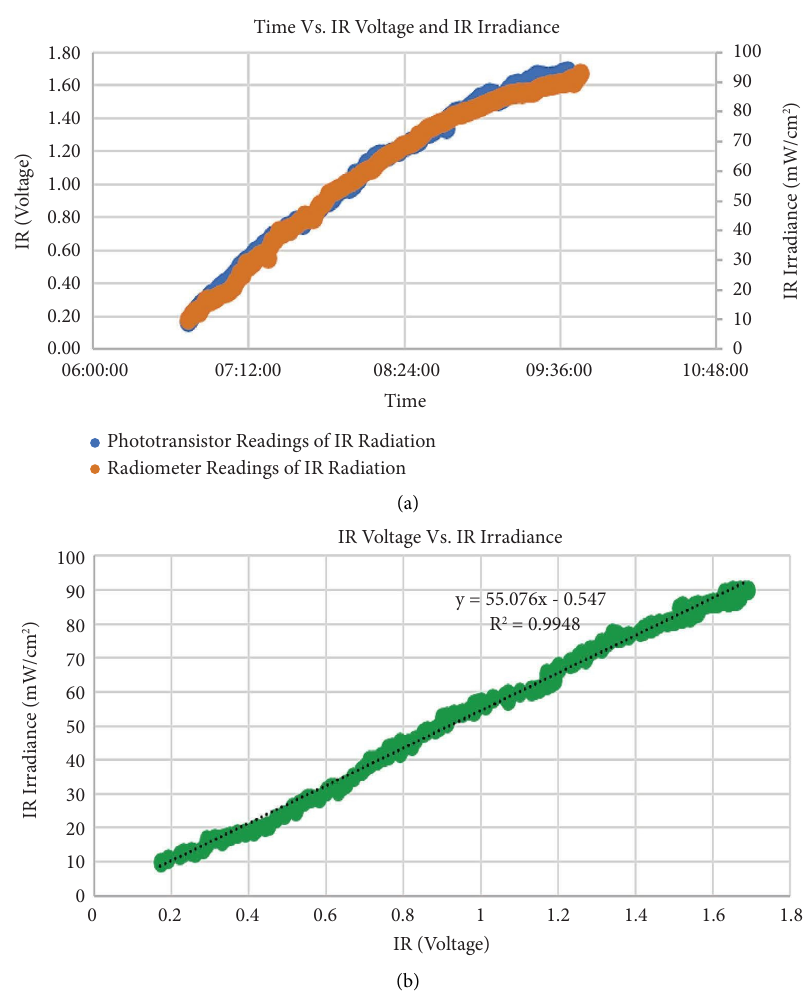
Figure 10: (a) Te relationship between time, aluminum-covered phototransistor’s voltage (blue), and IR irradiance (orange) (b) Te linear curve between IR phototransistor voltage and IR